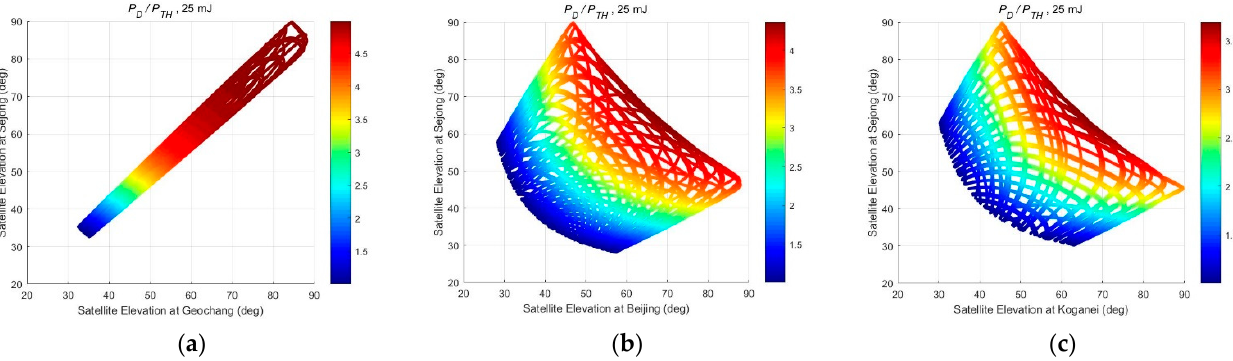
Figure 9. Ratio of detecting probability to threshold value for receiving one photoelectron from Ajisai’s reflective mirror in satellite elevation space. ( a ) Sejong − Geochang, ( b ) Sejong − Beijing and ( c ) Sejong − Koganei.